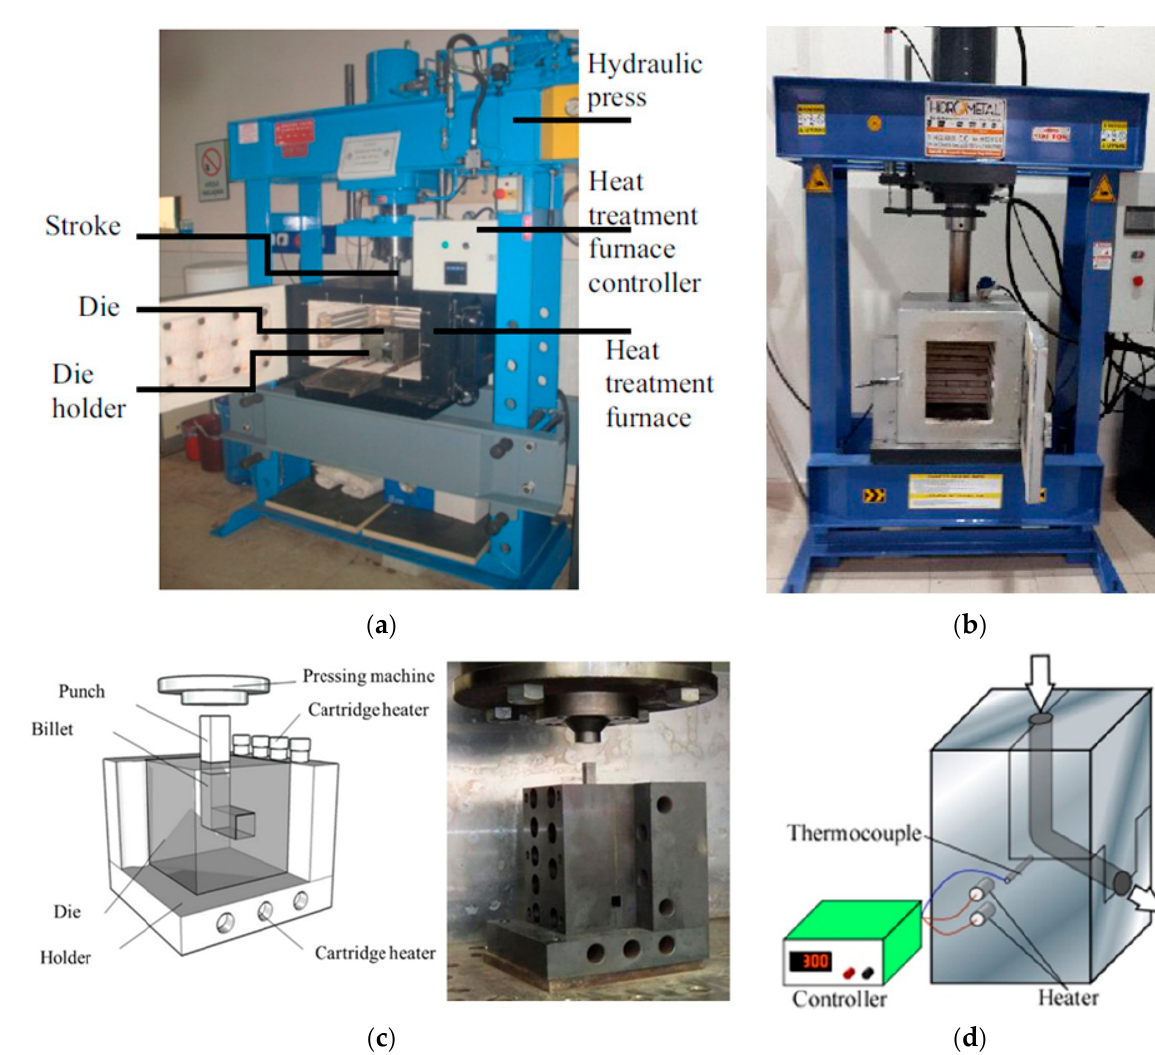
Figure 6. ( a , b ) Heating process of the mold in the oven [56,57]; ( c , d ) The process of placing a resistance in the mold [58,59].